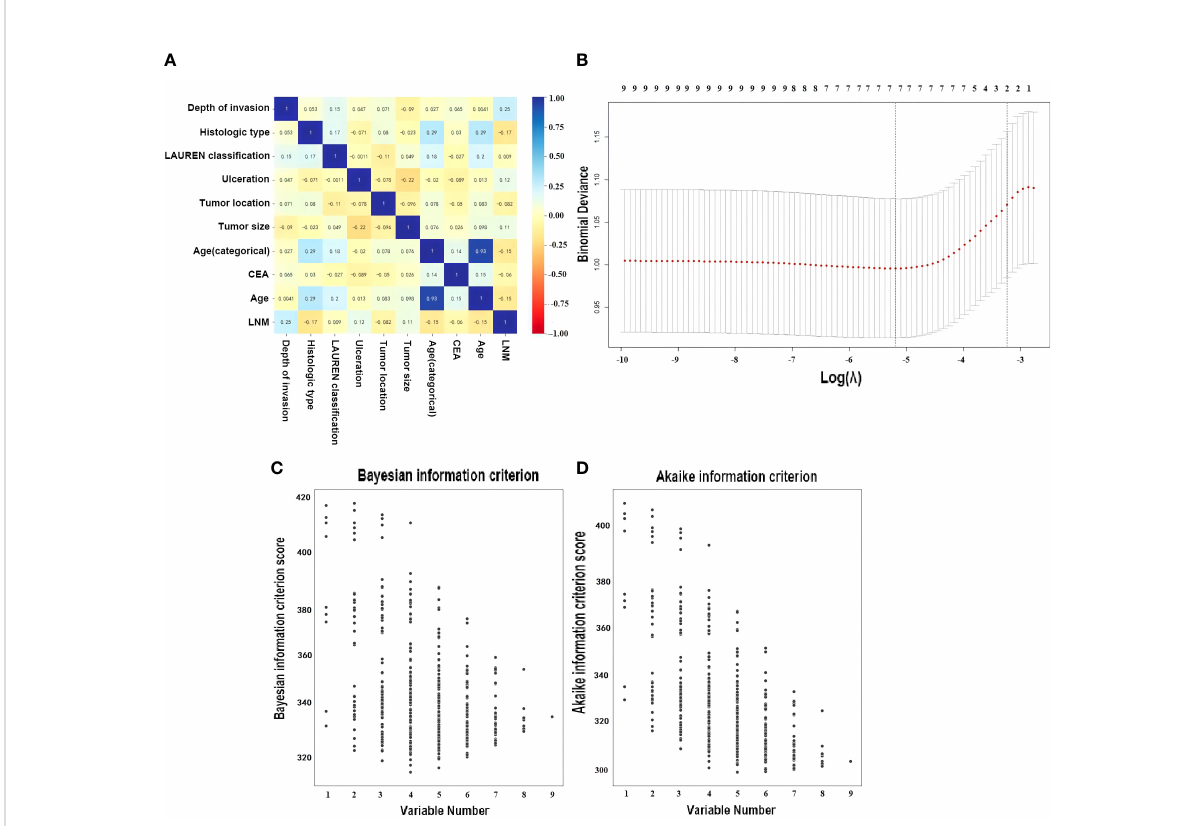
FIGURE 2 Optimal variable combination selection. (A) Correlation matrix of variables. (B) Result by Least Absolute Shrinkage and Selection Operator (LASSO). Here, the partial likelihood deviance (binomial deviance) curve was plotted in log( l ) scale. Dotted vertical lines were drawn at the values of log( l ) with minimum mean squared error (MSE) and the maximum log( l ) of one SE of the minimum MSE. The best features were selected with minimum mean squared error (MSE) from the fi ve cross-validation folds, with lambda value 0.00558, log( l ) is − 5.19. One SE of the minimum MSE with lambda value 0.03936, log( l ) is − 3.24. (C) Dot plot performed by Bayesian Information Criterion (BIC) for all possible models (disregarding potential transformations and interactions) employing none, any or all of the seven selected risk factors, a lower BIC indicates a better fi t (52). (D) Dot plot performed by Akaike Information Criterion (AIC), a lower AIC indicates a better fi t